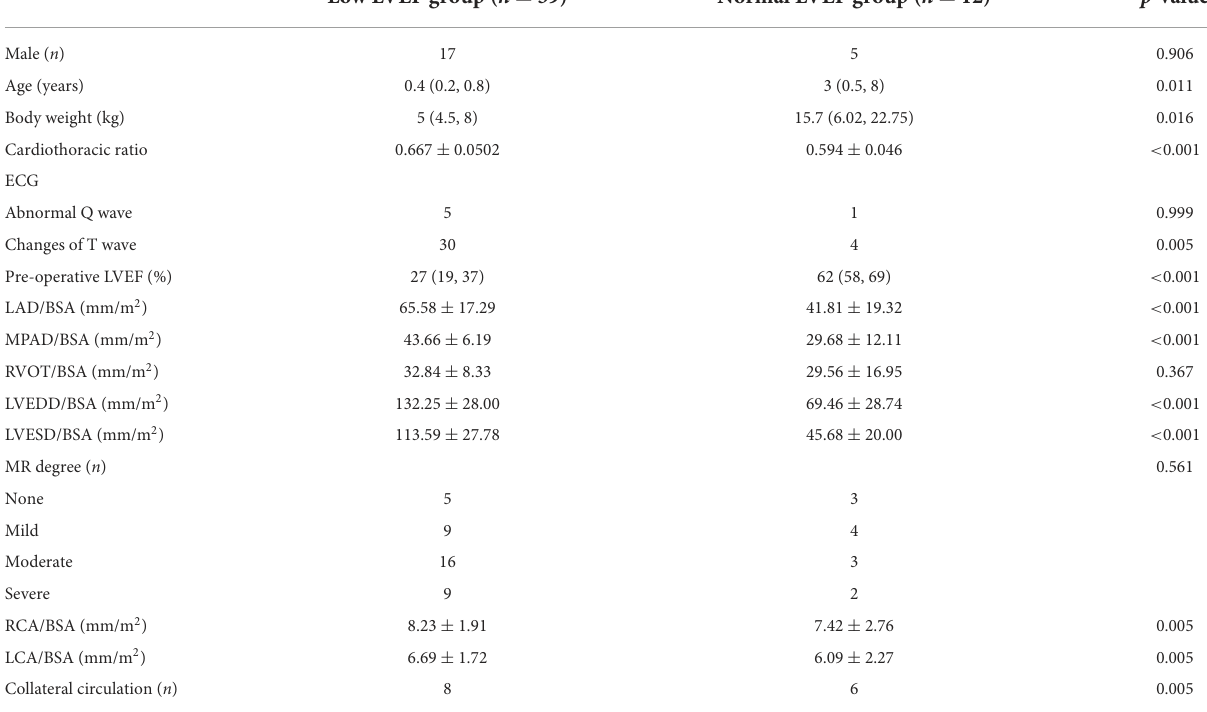
TABLE 1 Pre-operative data of